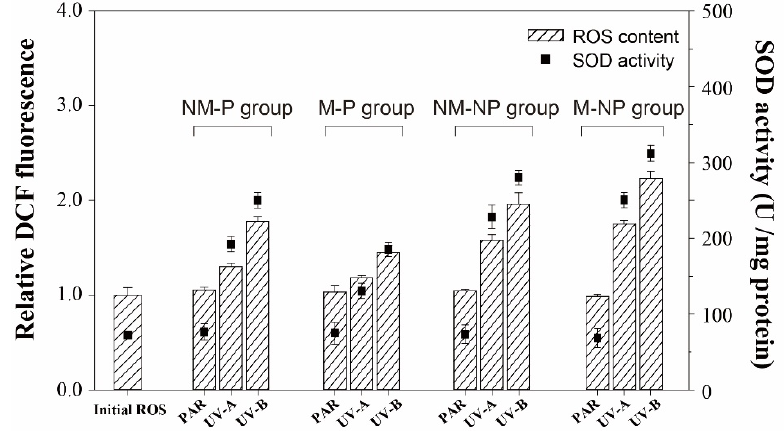
Figure 3. ROS in the cells of M. aeruginosa (vertical bar) and algal SOD activity (scatter) after 5 h of PAR, UV-A or UV-B radiation.